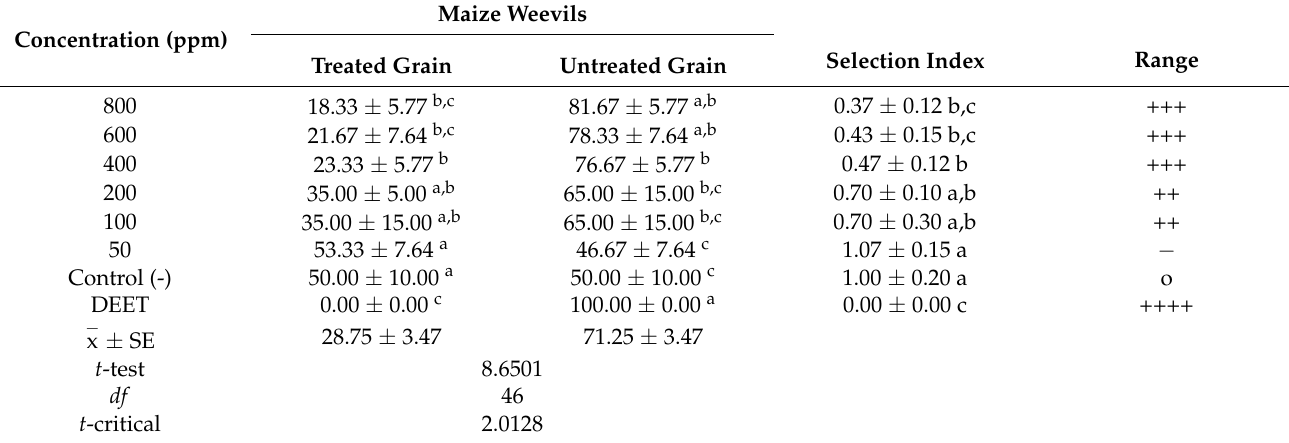
Table 6. A selection index of Sitophilus zeamais on treated and untreated maize grain with the Schinus molle essential